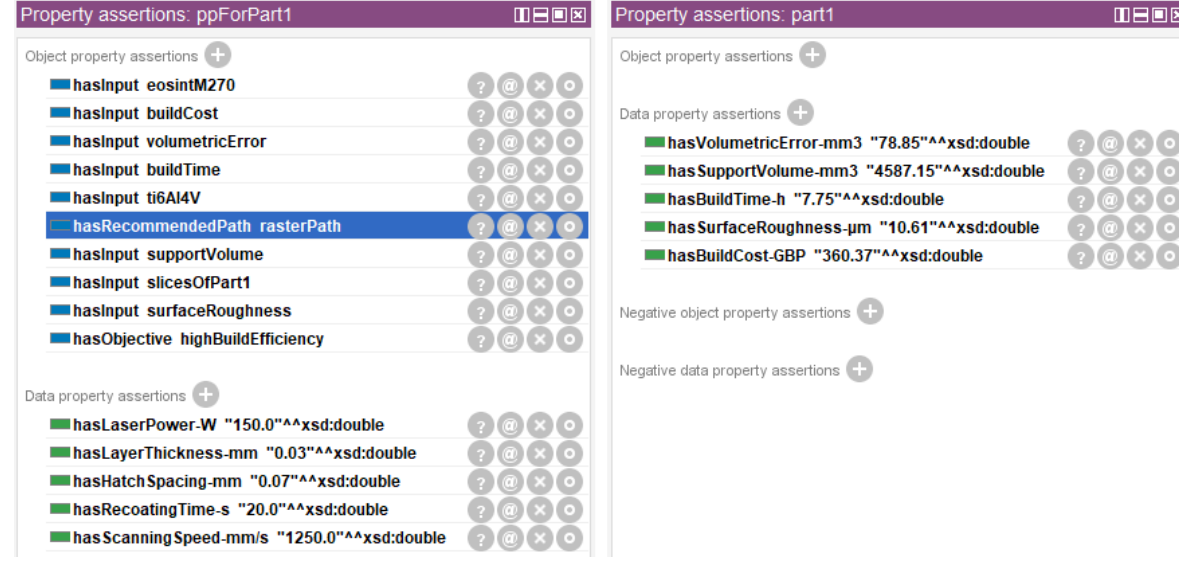
Figure 13. Results of path planning for the LPBF part in the